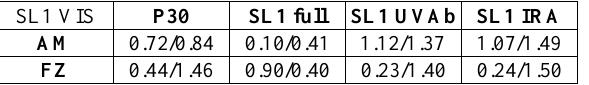
Table 12: comparisons between SL1 VIS dense cloud and spectral models for OBJ1(mean/RMS distances in mm)